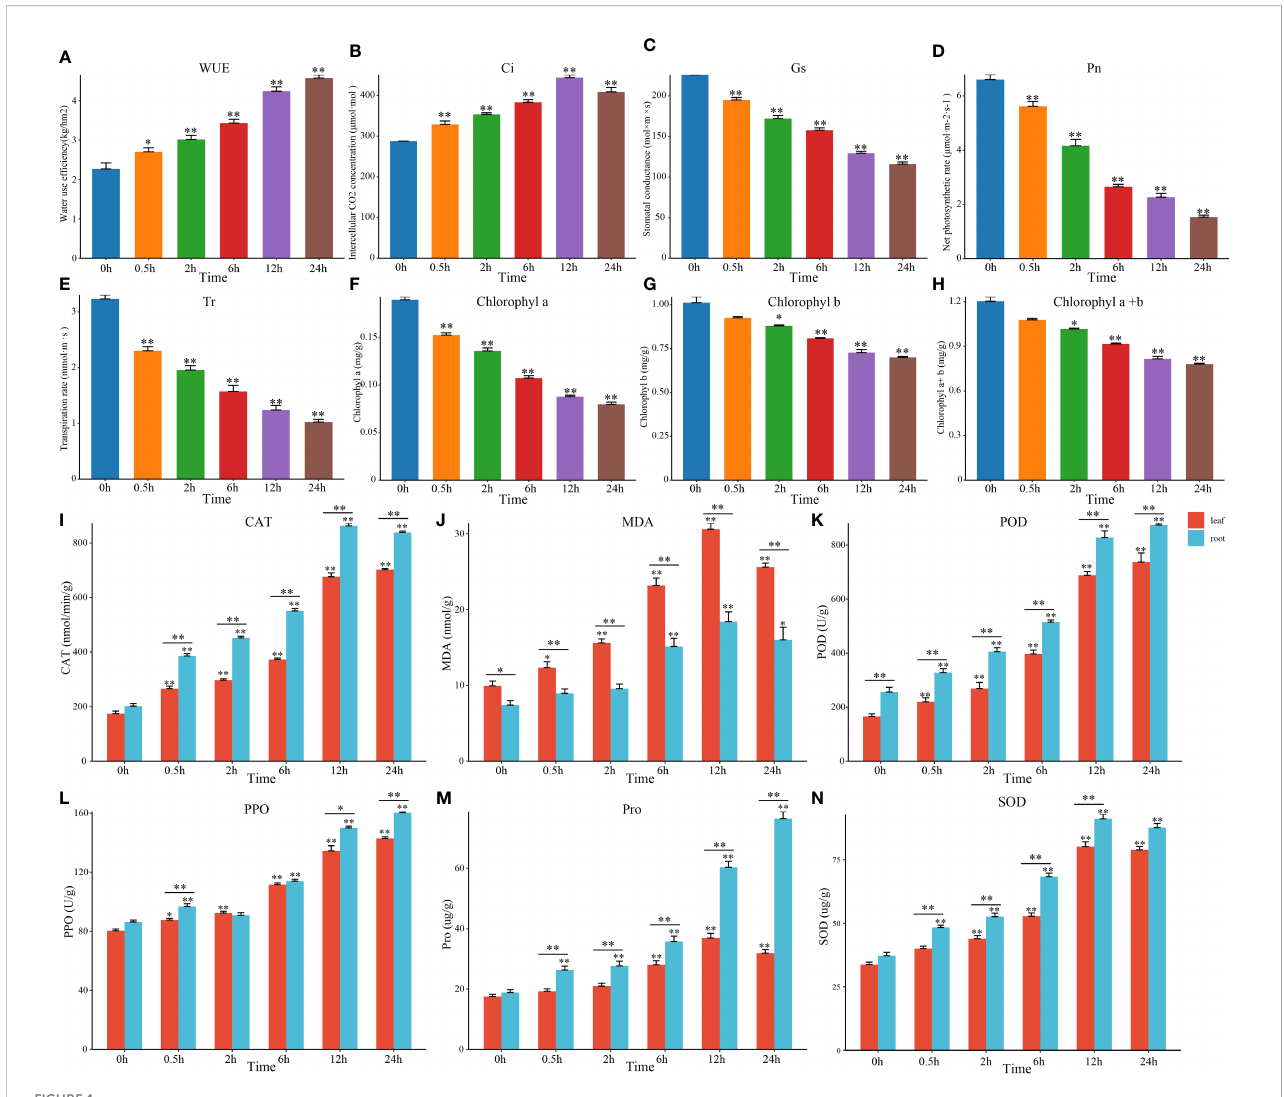
FIGURE 1 Changes in tomato photosynthesis and physiology under salt stress. (A – H) Changes in photosyn-thesis and the chlorophyll content in tomato leaves at DTP under NaCl treatment. (I – N) Changes in tomato physiological indices at DTP under salt stress. (*P-value < 0.05; **P-value <